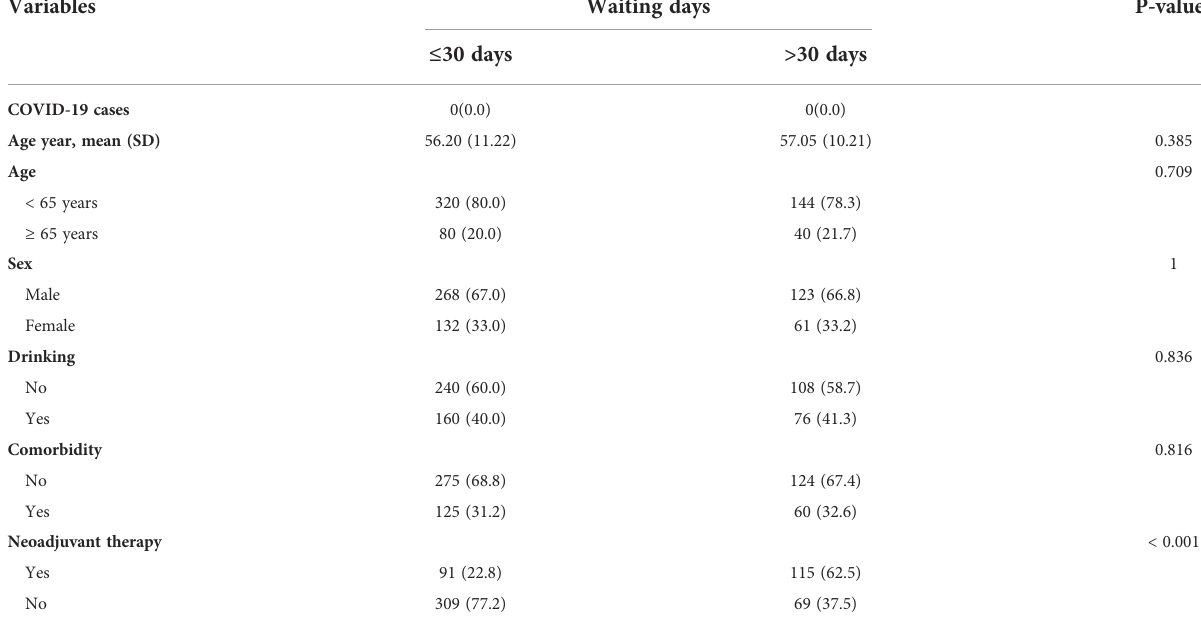
TABLE 2 Clinical characteristics of patients according to the waiting time for total